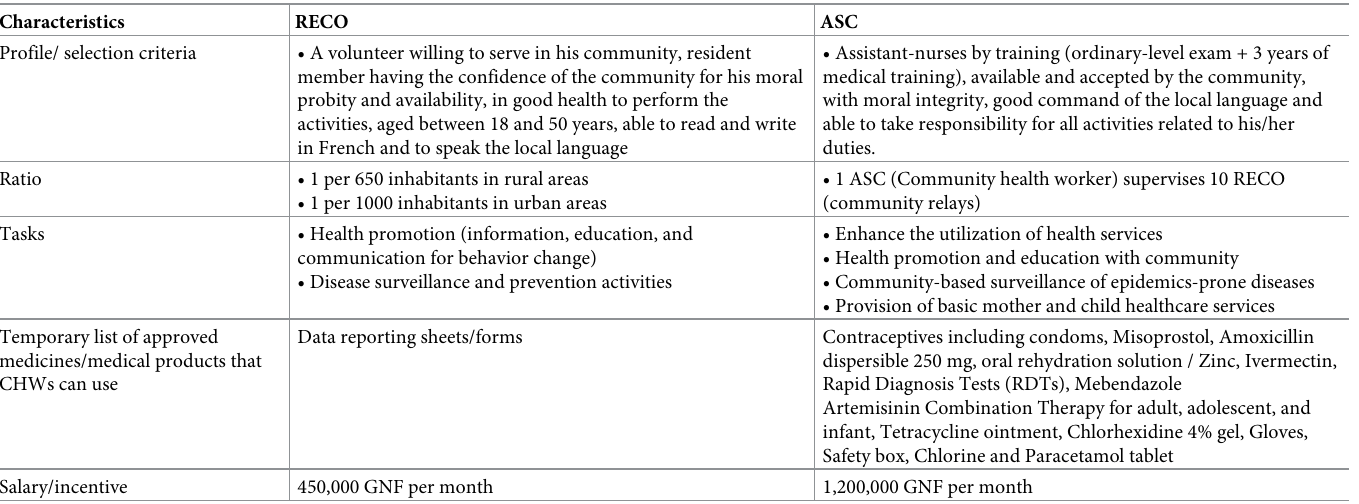
Table 2. Profile and roles of community health workers.